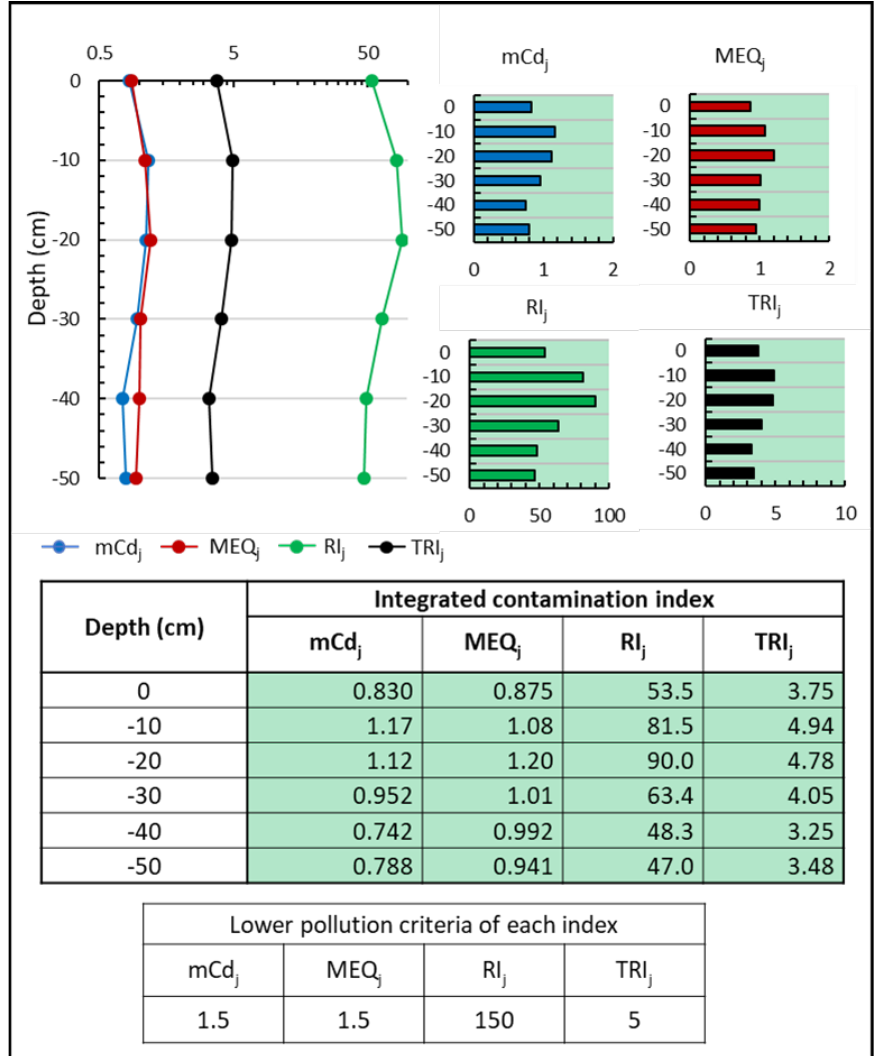
Figure 6. Profile and values of the integrated pollution indices mCd j , MEQ j , RI j, and TRI j.